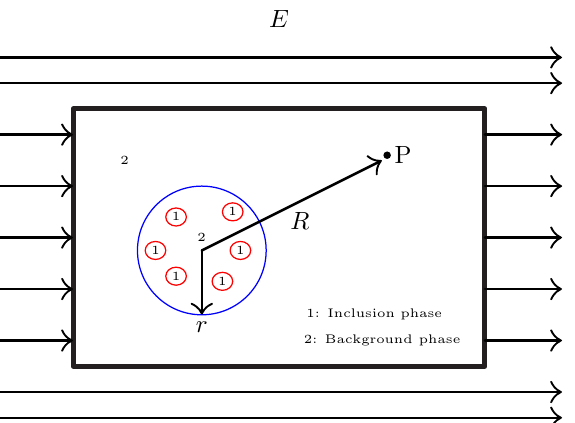
Figure 1. Schematic representation of Maxwell-Garnett approximation. The distance of point P from the center of sphere is very large compared to the sphere size, i.e., r (cid:28) R . E is the applied electric